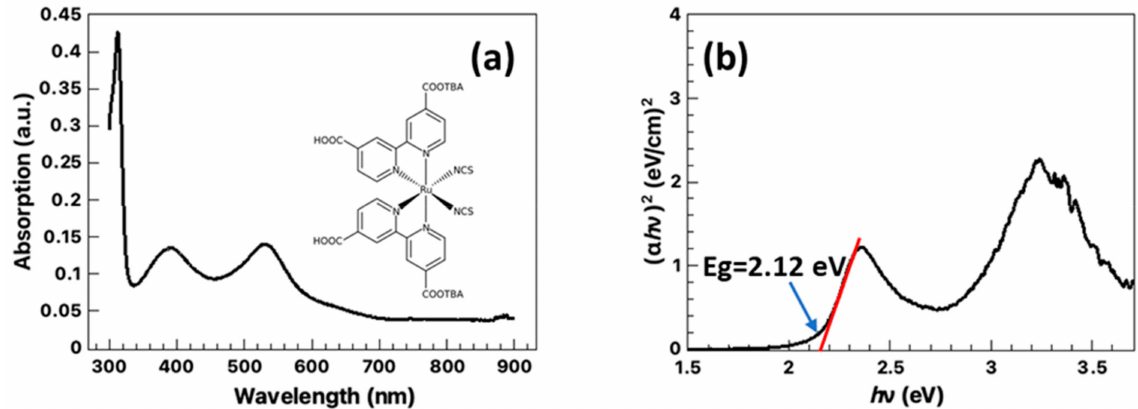
Figure 10. ( a ) UV–vis absorption spectra of solutions of N719 dye with molecule structure. ( b ) Ex- trapolation of the Tauc plot for bandgap calculations of N719 dye.